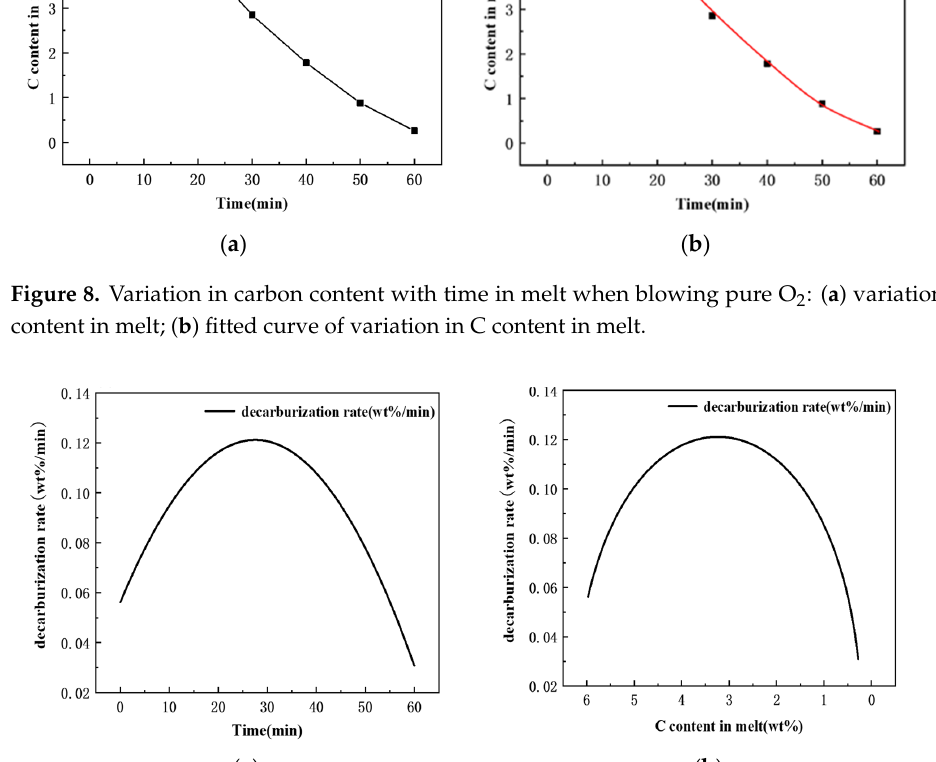
Figure 9. Variation in decarburization rate when blowing pure O 2 : ( a ) variation in decarburization rate with time; ( b ) variation in decarburization rate with C content. rate with time; ( b ) variation in decarburization rate with C